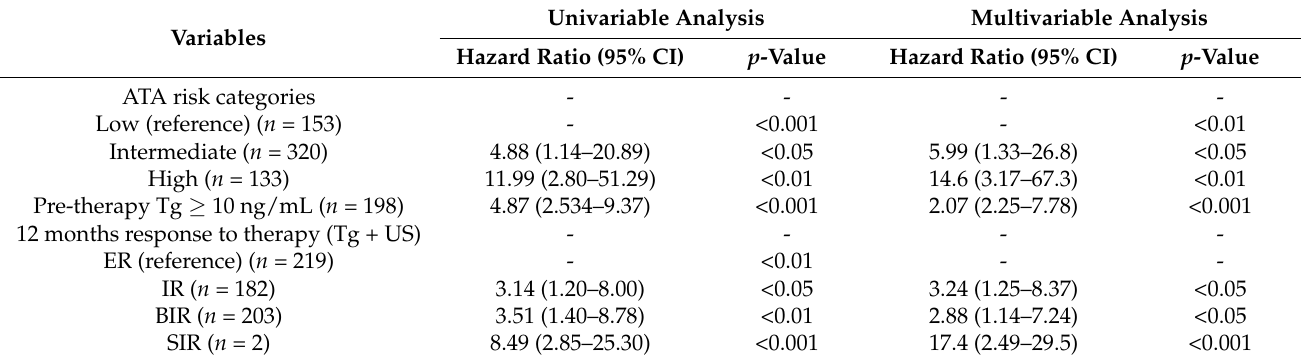
Figure 1. Event rate according to ATA risk categories. Table 4. Univariable and multivariable predictors of recurrence.